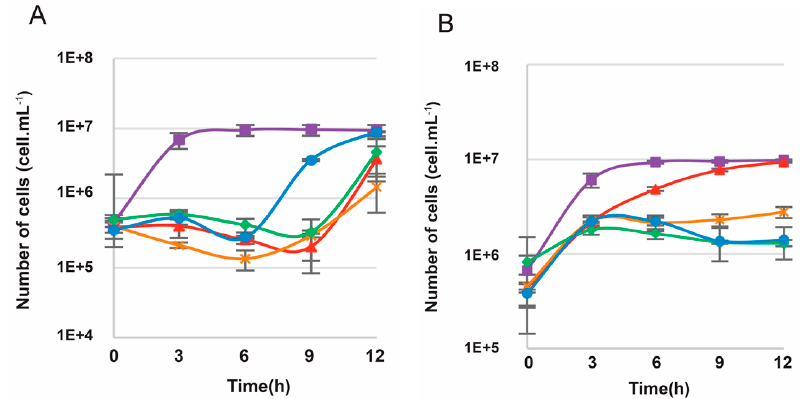
Figure 3. Growth curves of: T. kodakarensis KOD1 ( A ); and T. barophilus MP ( B ). The strains were cultivated at 85 °C and 0.1 MPa in TRM medium containing different concentrations of 6-MP: 0 µM ( ), 10 µM ( ▲ ), 50 µM ( × ), 100 µM ( ) and 250 µM ( ).